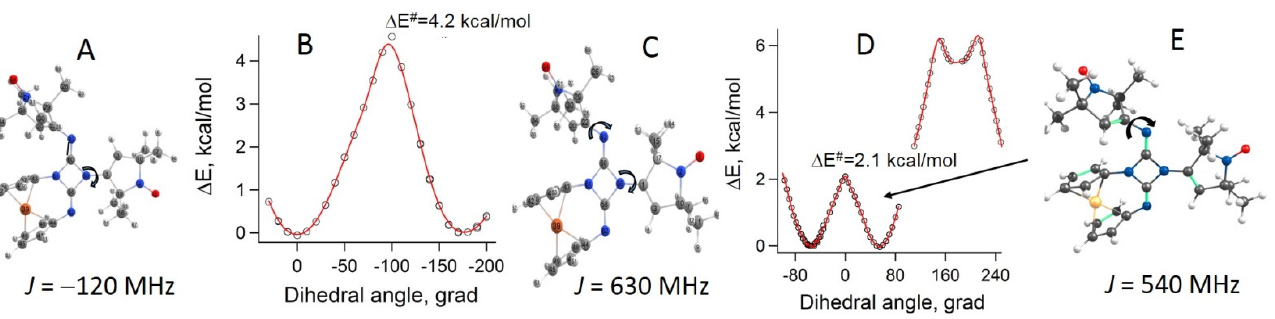
Figure 4. The energy scans ( B , D ) performed by variation of the dihedral angle with optimization of all other coordinates for the rotation around either the N3–C ( B ) or N5–C ( D ) bond for biradical 3 at the B97-D3/def2-TZVP level of Table 3 are also displayed: ( C ) after optimization of XRD structure, ( A ) after rotation around the N3–C bond, and ( E ) after rotation around the N5–C2 bond. ∆ E # stands for rotation barriers in kcal/mol, ∆ E stands for energy differences between minima in kcal/mol.